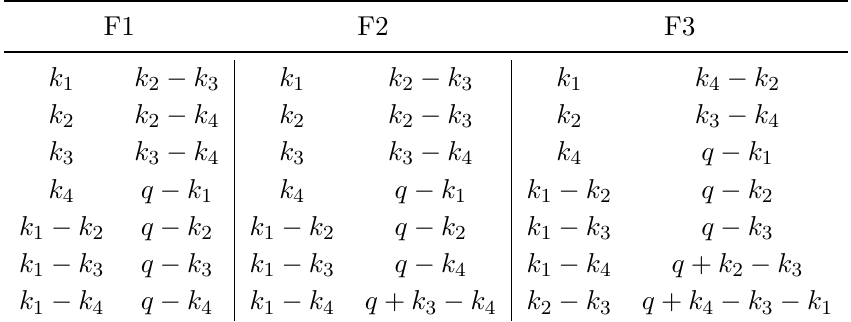
Table 1 . The three auxiliary topologies which label every diagram present in the calculation. The knowledge of cut propagators is re-inserted only after the matching of diagrams onto the topologies F1, F2 and F3. One can subsequently infer which combinations of cuts are required in each topology to accommodate every cut